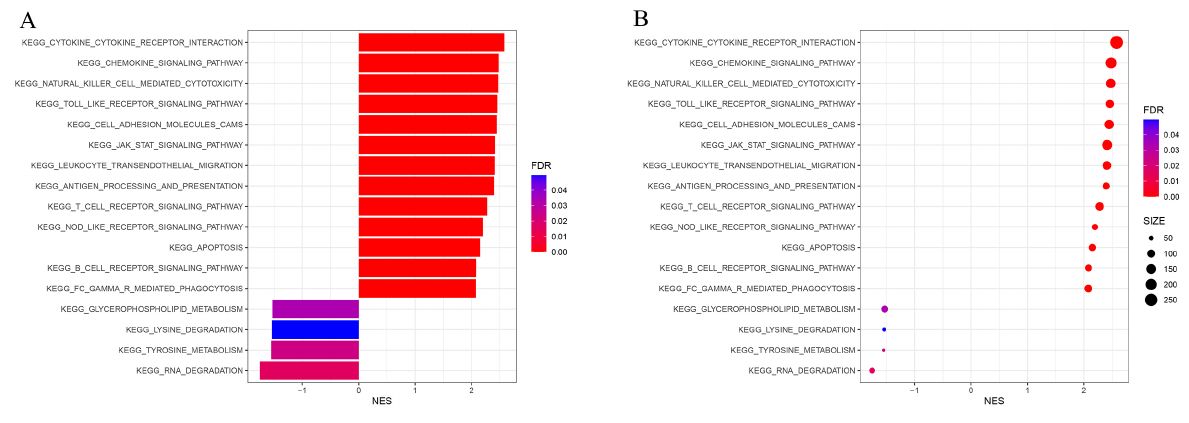
Figure 3. GSEA enrichment analysis. The bar plot ( A ) and dot plot ( B ) show KEGG pathway analysis of DEGs between two